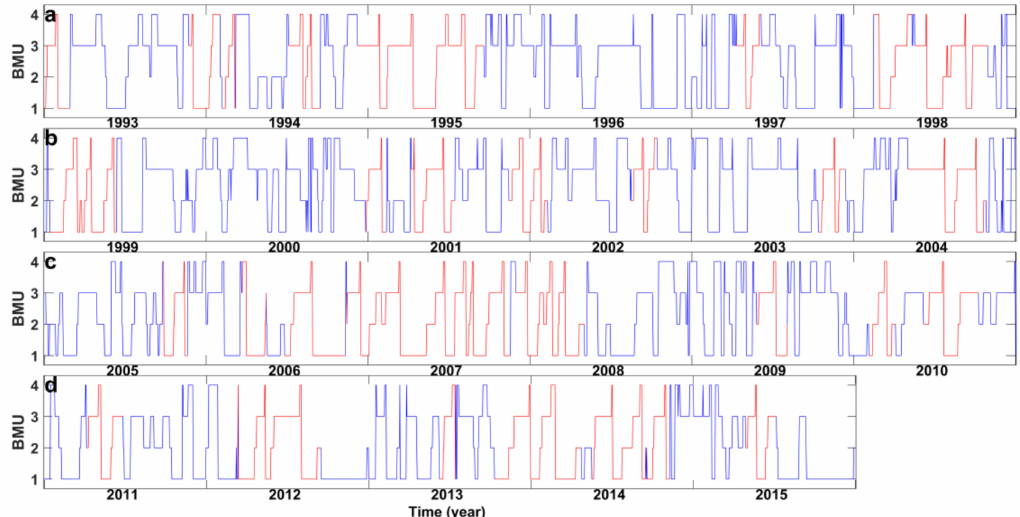
Figure 4. Time series of the BMU for the four patterns, as shown in Figure 2. On the y axis, 1, 2, 3 and 4 correspond to P1, P2, P3, and P4, respectively. The subgraphs ( a ), ( b ), ( c ), and ( d ) correspond to the period from 1993 to 1998, from 1999 to 2004, from 2005 to 2010, and from 2011 to 2015, respectively.